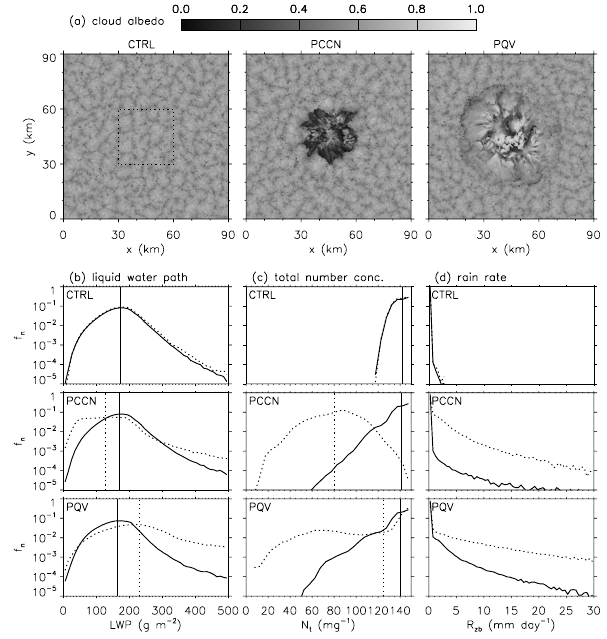
Fig. 5. Snapshots of (a) cloud albedo fields at t =6h and normal- ized PDFs of (b) liquid water path, (c) column-average total particle number concentration, and (d) cloud-base rain rate over 8h for ex- periments CTRL, PCCN and PQV. The center-square outlined by dotted lines in the upper-left panel is the area in which specific per- turbations are applied; distributions of quantities sampled inside the square are represented by dotted lines and outside by solid lines; the corresponding vertical lines indicate median